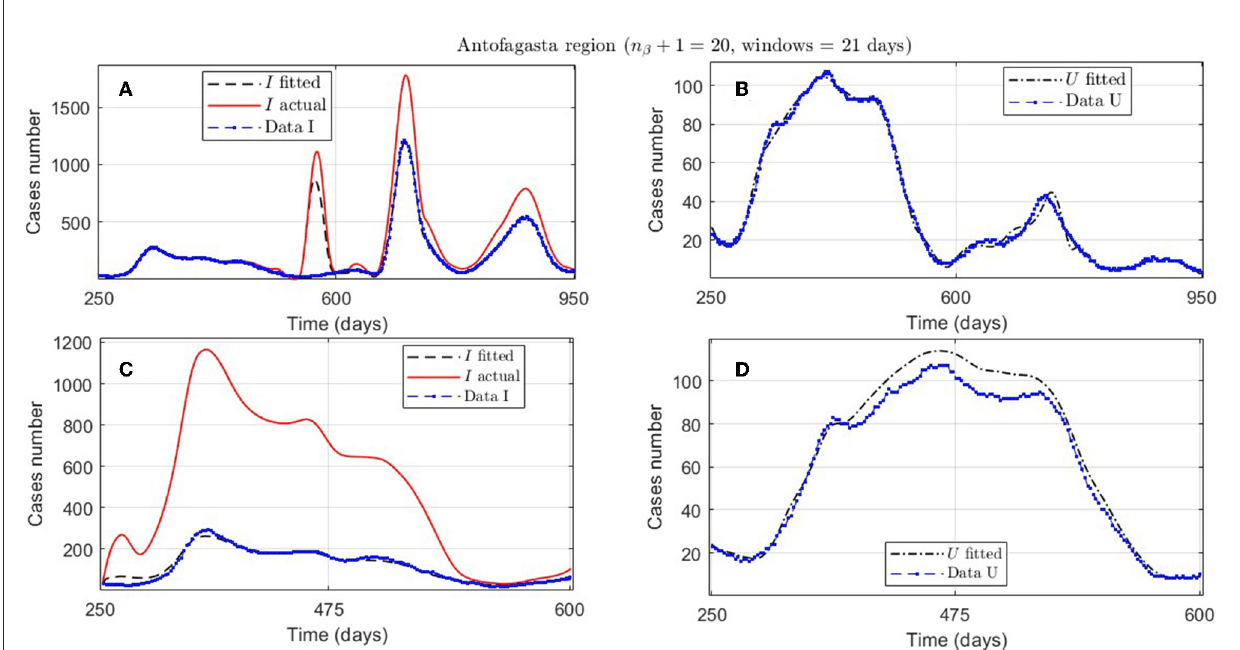
FIGURE8 Fitted incidence curves in the Antofagasta region, Chile; UB τ (C, D) 7 November 2020 to 23 October 2021.